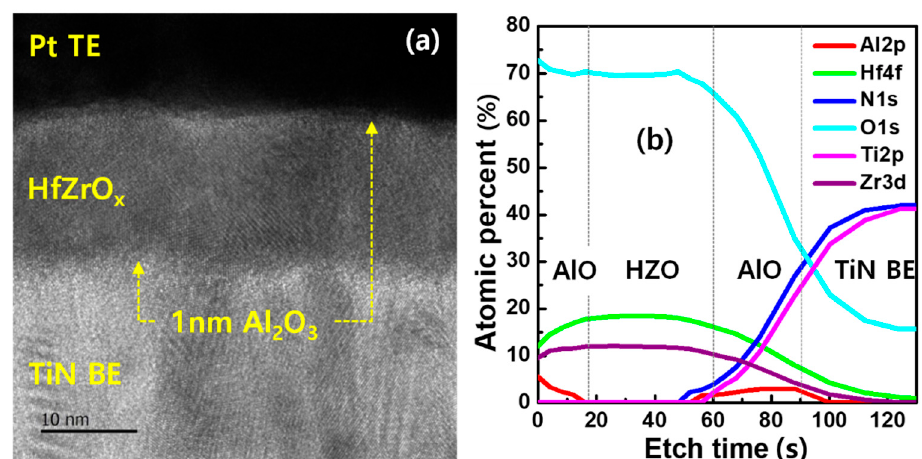
Figure 1. The XPS of the as-deposited 17-nm-thick HZO layer.